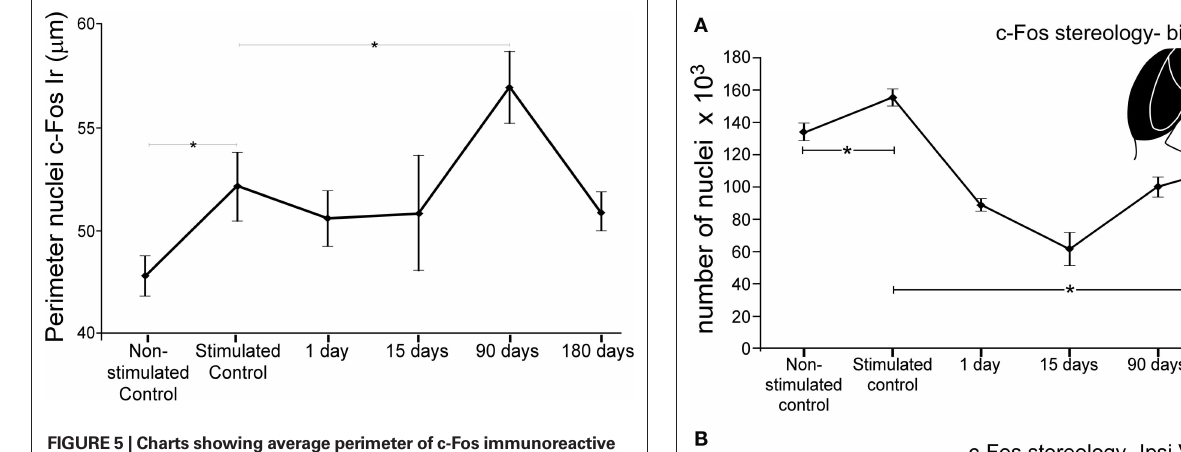
Figure 5 | Charts showing average perimeter of c-Fos immunoreactive neuronal nuclei. Perimeter increases significantly (*mean ± 2SD) between non-stimulated and stimulated controls, also after 90 days post-lesion (see text for details).